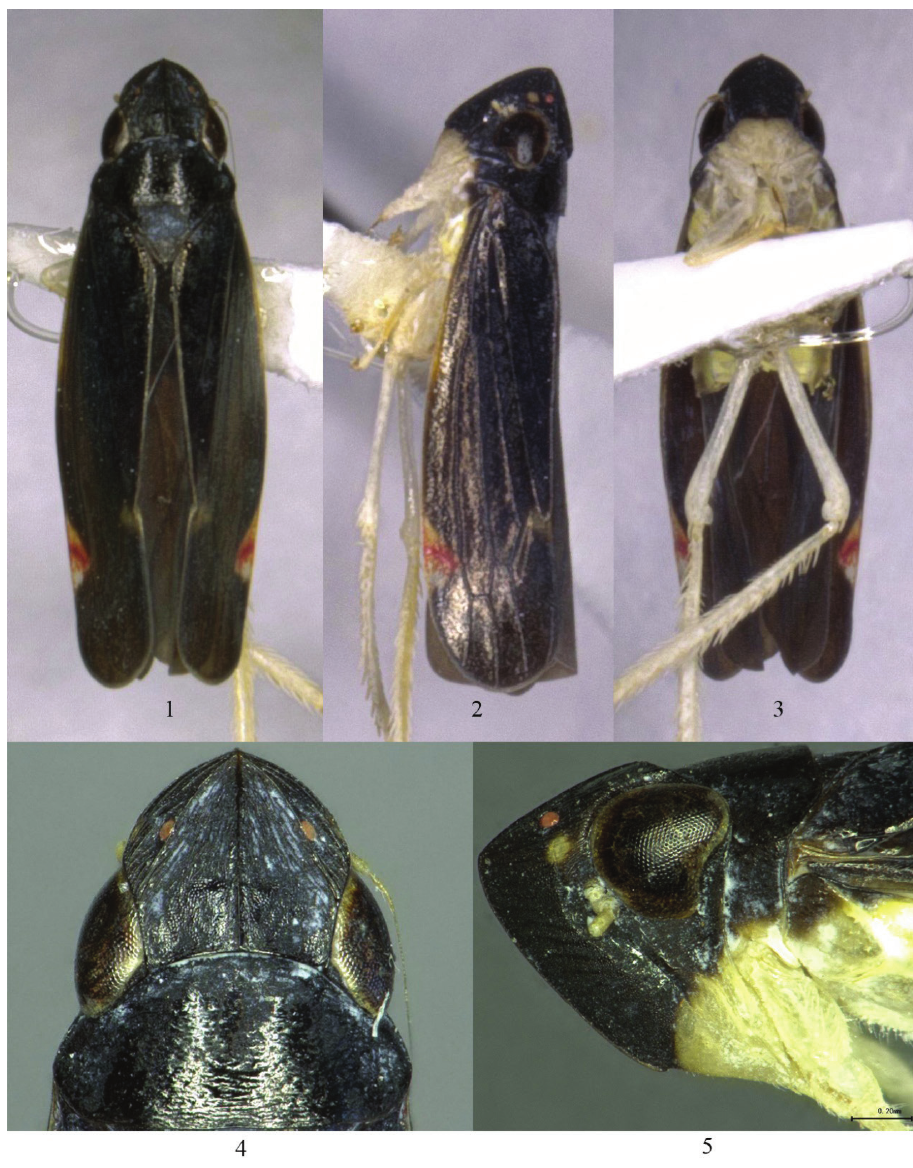
dorsal view, lateral